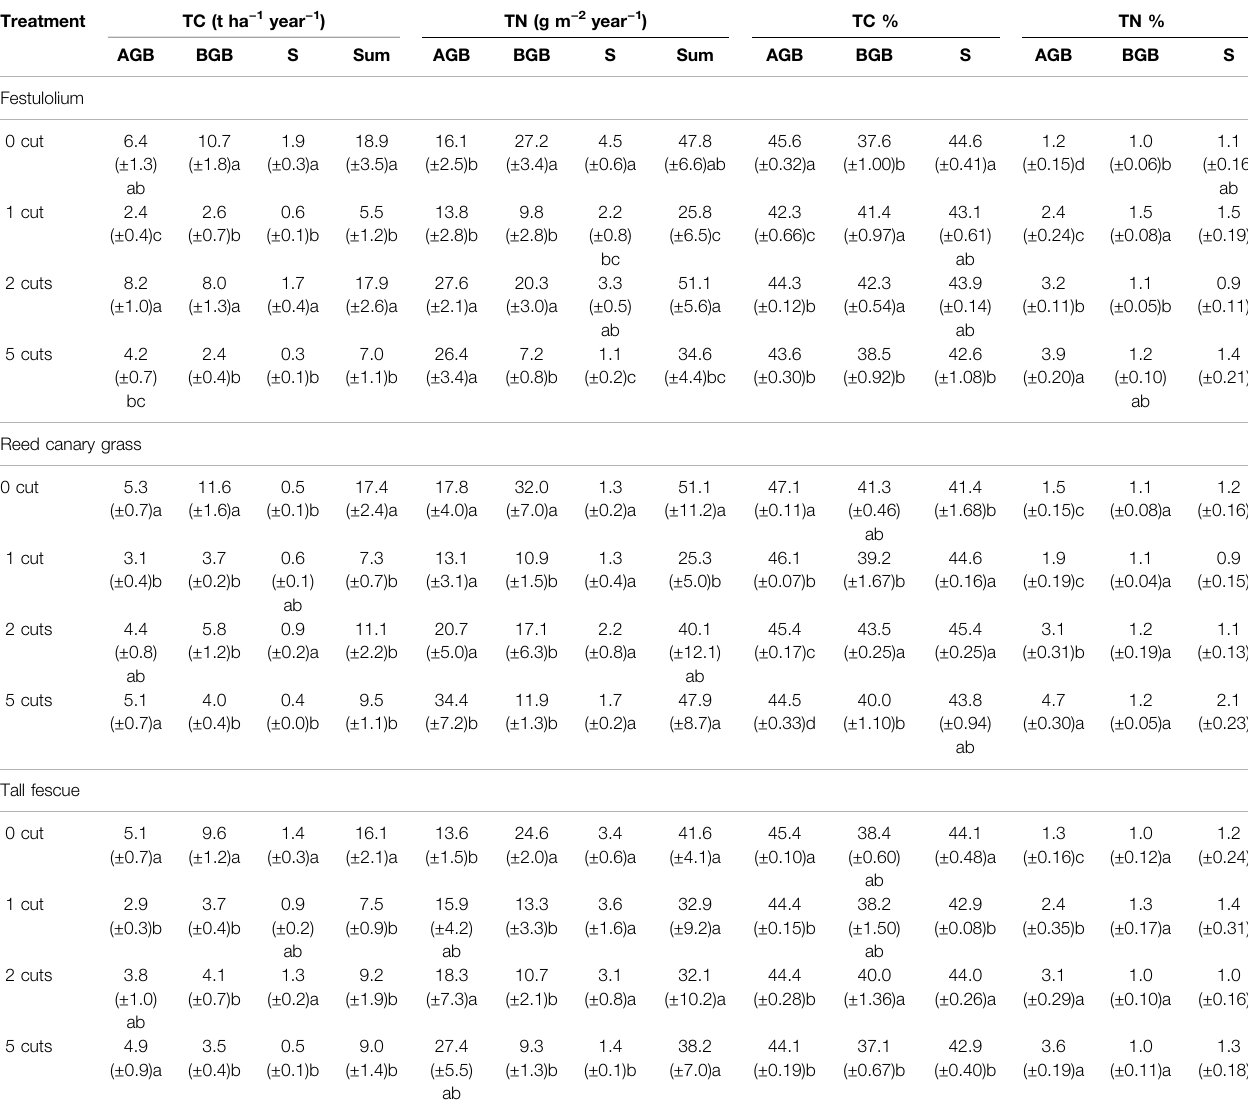
TABLE 3 | Yields of total carbon (TC) and total nitrogen (TN), as well as TC and TN content in percentages, of aboveground (AGB), belowground (BGB), and stubble (S) biomass for the various species and treatments. Total yields for above- and belowground plant fractions are indicated as sums. Letters indicate differences between treatments, where treatments with the same letters are not signi fi cantly different. Standard error is given in brackets (n (cid:2)